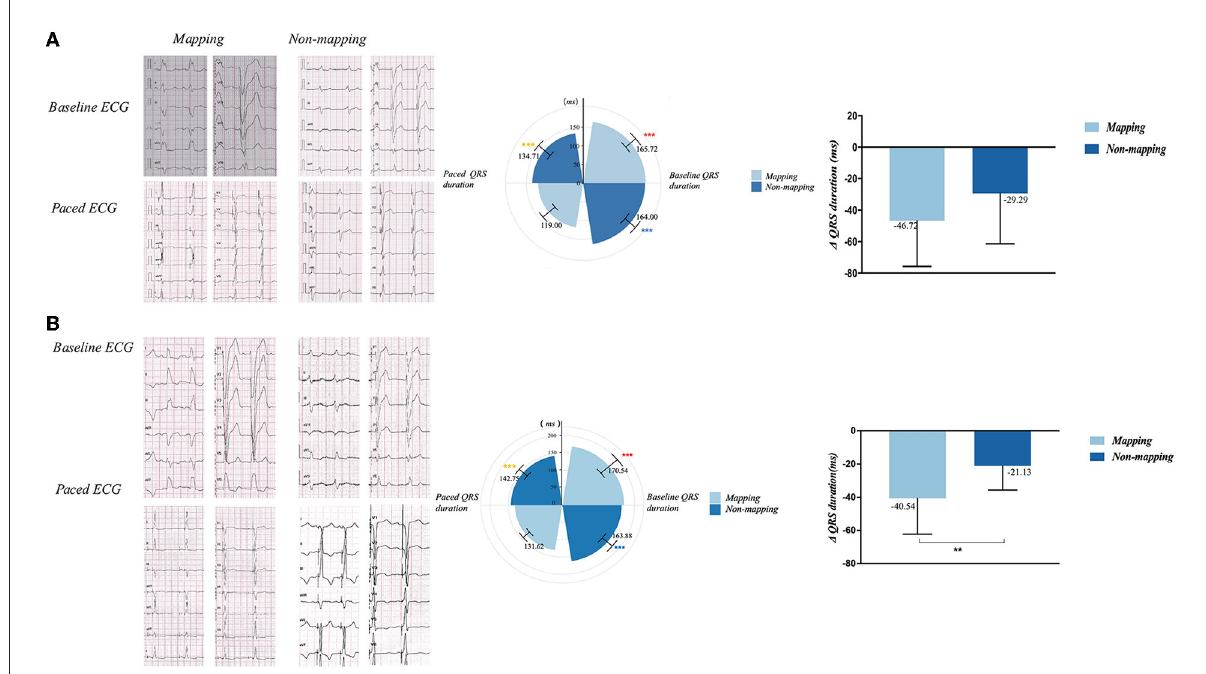
FIGURE5 QRS duration and QRS duration variation of mapping and non-mapping group in LBBAP (A) and CVP (B) before and 1-week after the operation. *** p < 0.001 vs. paced QRS duration in mapping group; *** p < 0.001 vs. paced QRS duration in non-mapping group; *** p < 0.001 vs.